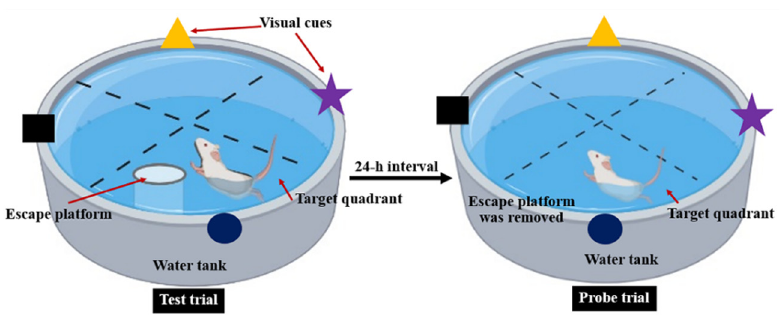
Figure 2. Representative procedure for Morris water maze test.